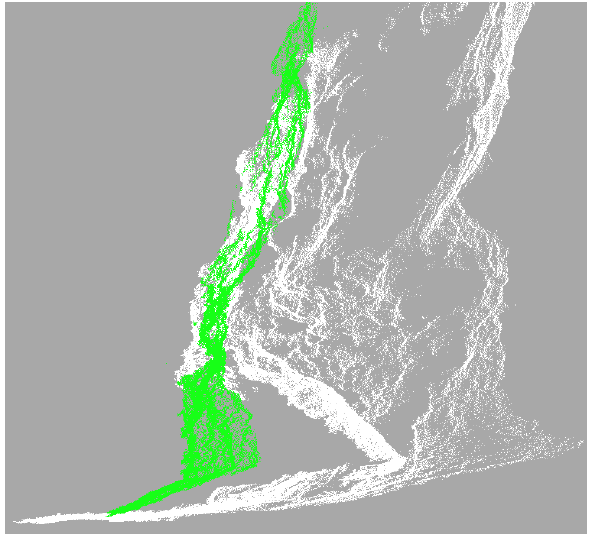
Figure 5: Erosion on south-end of the study site, focus is on a new notch.